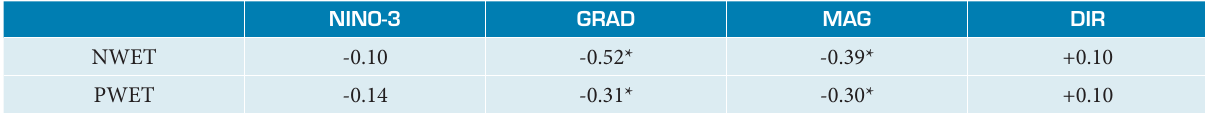
Table 2. Pearson correlation coefficients ( r ) between NWET or PWET and NINO3, GRAD, MAG or DIR. Period: 1979-2016, except 2006 (37 years). NINO-3 GRAD MAG DIR NWET -0.10 -0.52* -0.39* +0.10